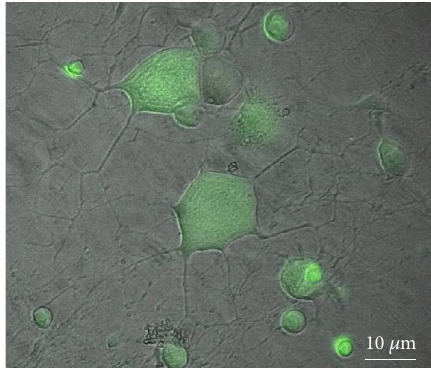
Figure 3: Calcein-AM-stained fl uorescent image of the DRG culture.